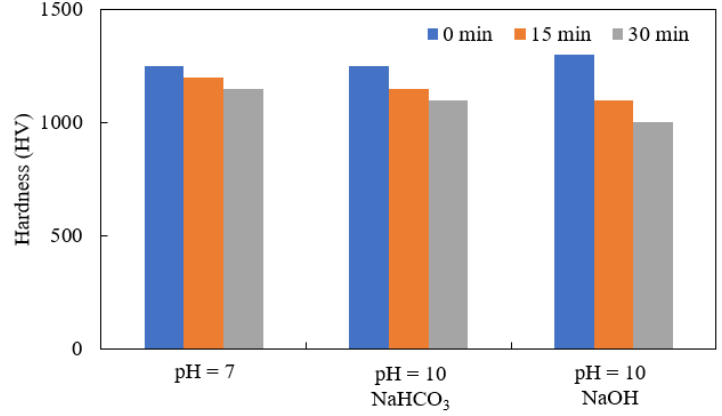
Figure 9. Variation in hardness with soaking time.